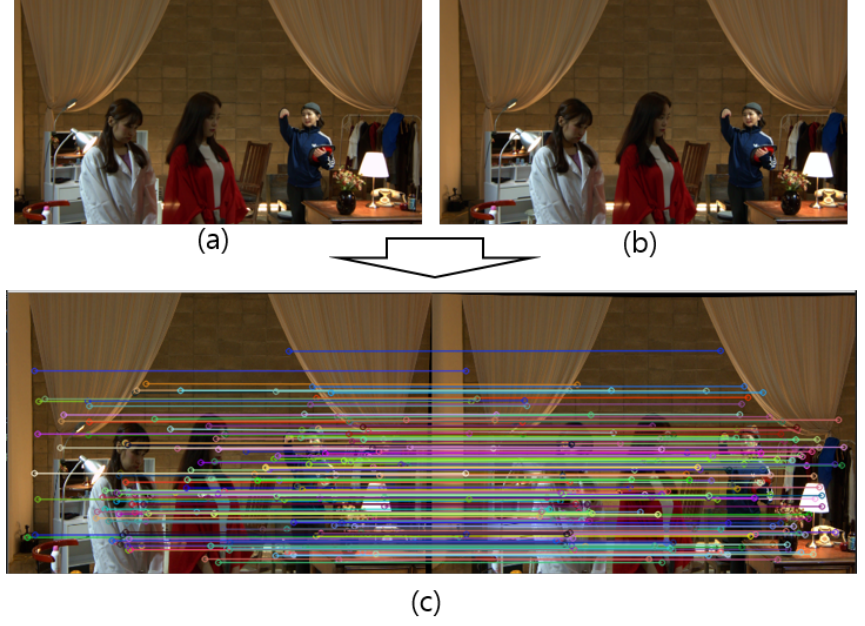
Figure 2. Once the feature is extracted using SIFT from two adjacent images ( a , b ), feature matching between the images is carried out using RANSAC ( c